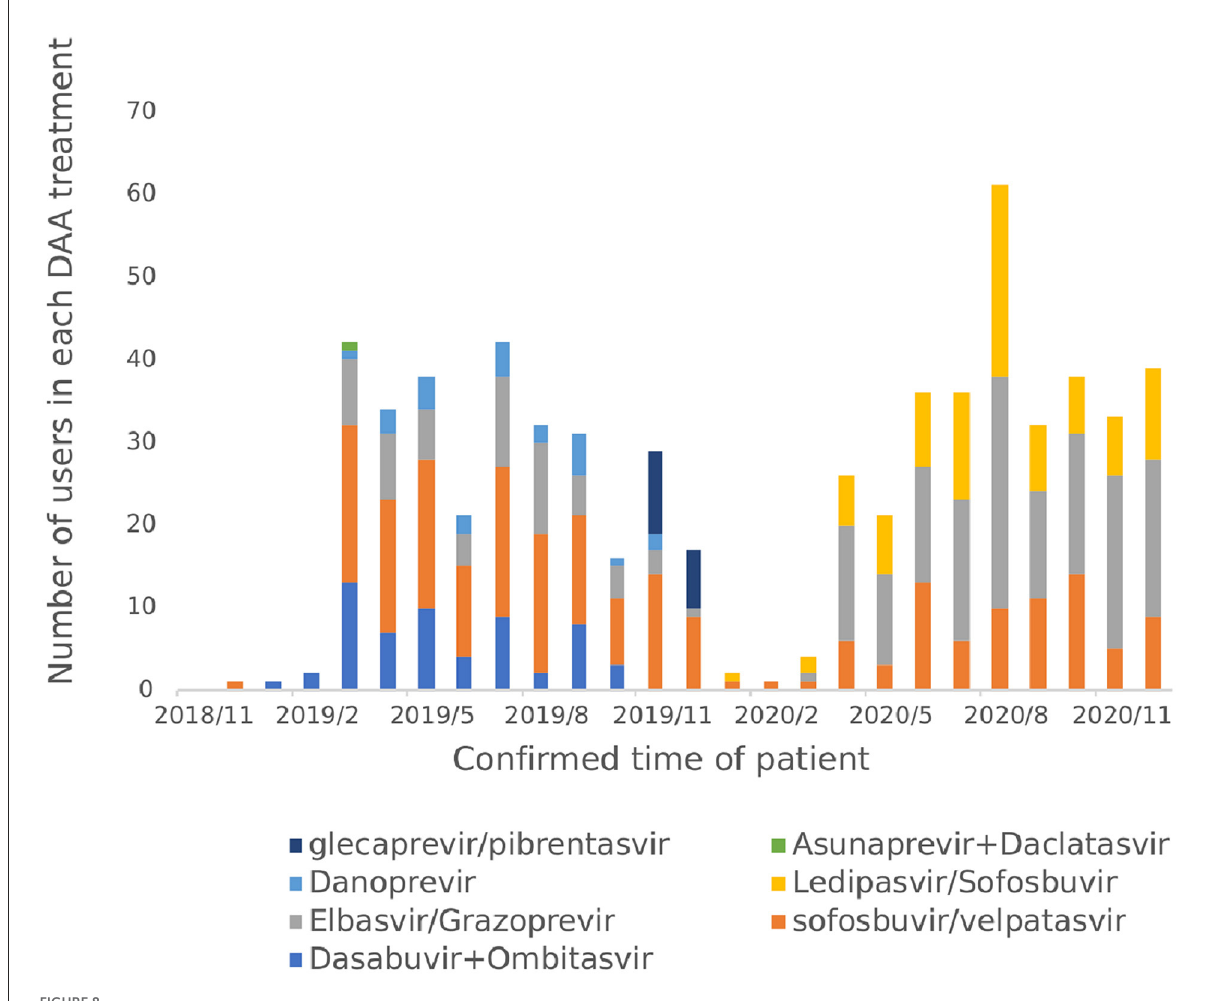
FIGURE8 Number of users in each DAA